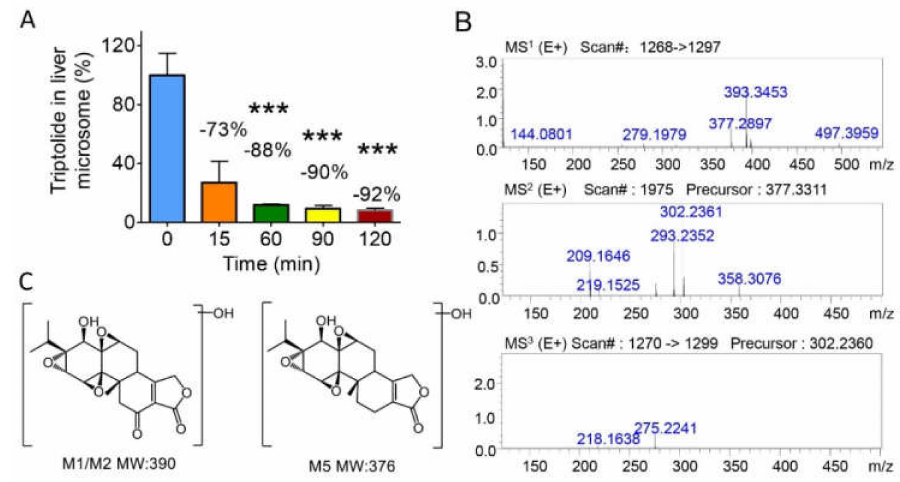
Figure 5. The metabolites of triptolide in liver microsomes. ( A ) The level of triptolide incubated with rat liver microsomes at di ff erent time points (0 min, 15 min, 60 min, 90 min, and 120 min). ( B ) The MS n data of the triptolide metabolite M5 (molecular weight: 376) in liver microsomes. ( C ) The possible structure of the triptolide metabolites M1 / M2 and M5 in rat liver microsomes. Data are presented as mean ± SD, and two-tailed Student’s t test were used for analysis (*** p <